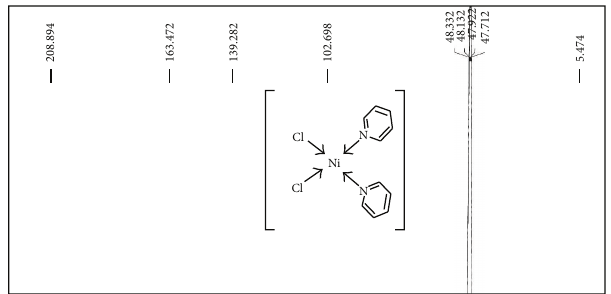
Figure 6: 13 C-NMR spectrum of cis -[Ni(C 5 H 5 N) 2 Cl 2 ].